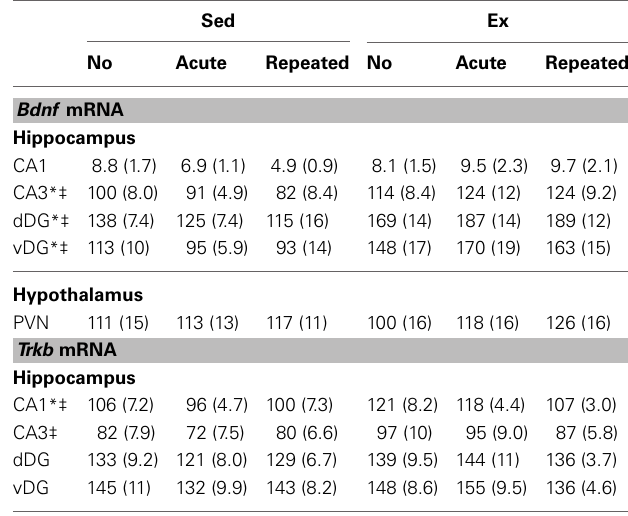
Table 3 | Stress and wheel running regulation of central Bdnf and Trkb mRNA expression. Sed Ex No Acute Repeated No Acute